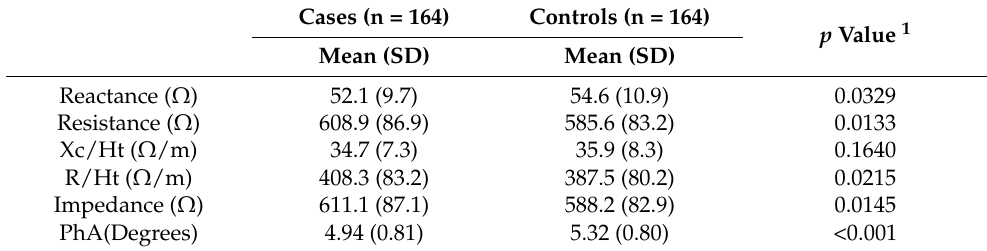
Table 5. Shows the bioelectrical characteristics.